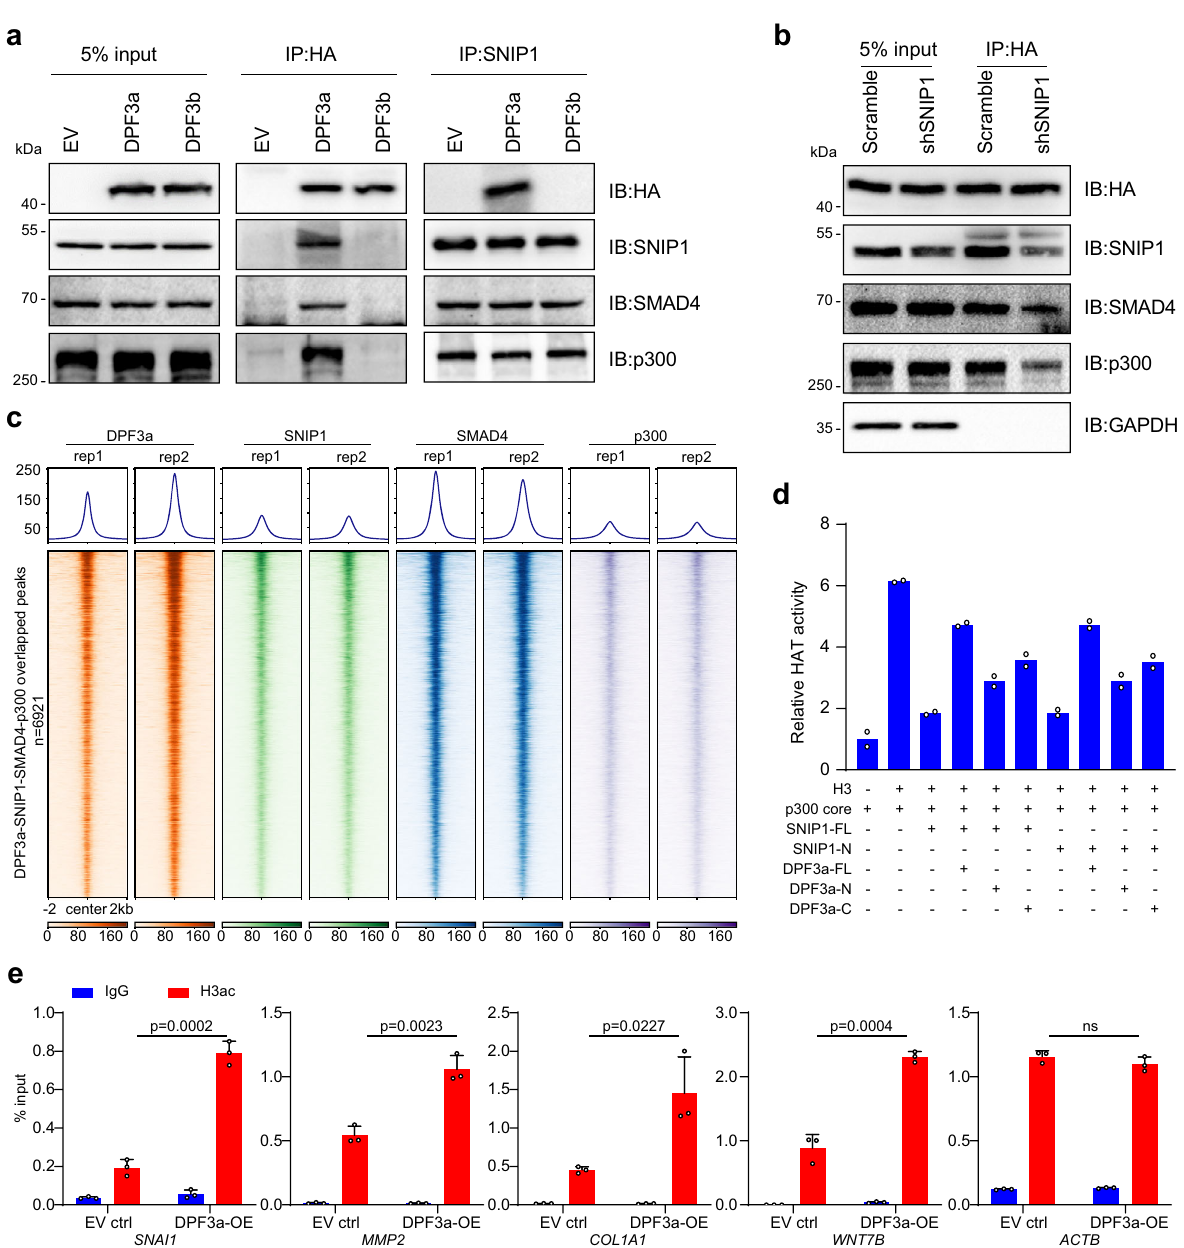
Fig. 6 | DPF3a-SNIP1 binding released the inhibitory effect of SNIP1 on p300 activity.a DPF3a, SNIP1,SMAD4,andp300forminacomplex.HA-taggedDPF3a or endogenous SNIP1 protein was immunoprecipitated and followed by immunoblotting using antibodies against SMAD4 and p300 to detect the co- precipitated endogenous SMAD4 and p300. Three independent experiments were performed and similar results were obtained. b SNIP1 bridges DPF3a to SMAD4 and p300. SNIP1 was knocked down in 786-O cells using shRNA. HA- tagged DPF3a protein was immunoprecipitated using anti-HA magnetic beads and followed by immunoblotting using antibodies against SNIP1, SMAD4, and p300 to detect the co-precipitated endogenous SNIP1, SMAD4, and p300. Input lanes represent 5% of total protein lysate. Three independent experiments were performed and similar results were obtained. c Co-occupancy of DPF3a, SNIP1, SMAD4,andp300onthegenome.Averagepro fi lesandheatmapsofnormalized